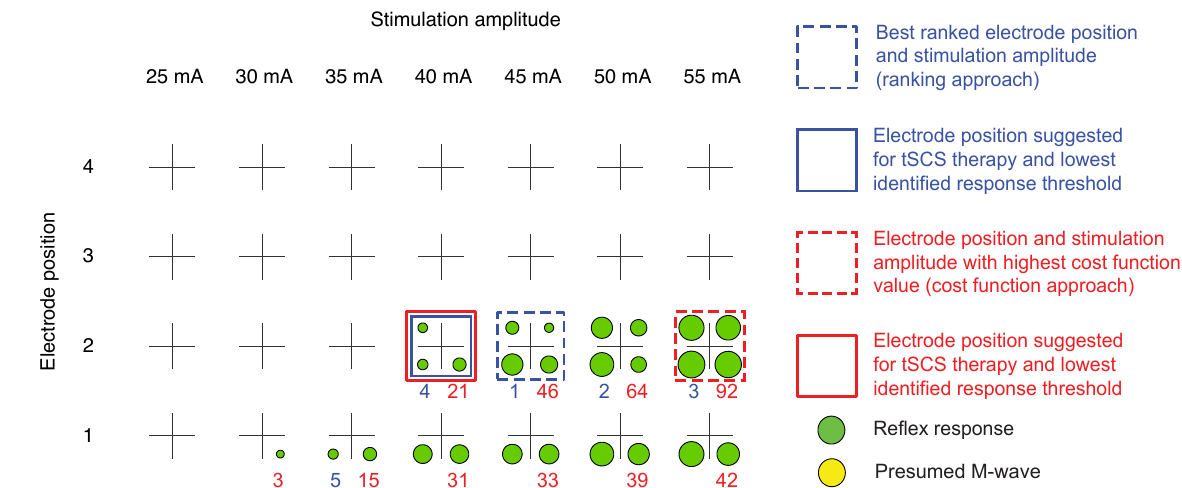
Figure 3. Rating details matrix derived for a neurologically intact individual, C1. In addition to the color codes, reflex peak- to-peak amplitudes are reflected by the size of the colored circles representing the four muscle groups studied. If no response had been elicited, the circle shrank to a dot. Blue numbers are ranks 1–5 as derived from the ranking approach, and red numbers are cost function values J calculated in the cost function approach, with higher values signifying favorable